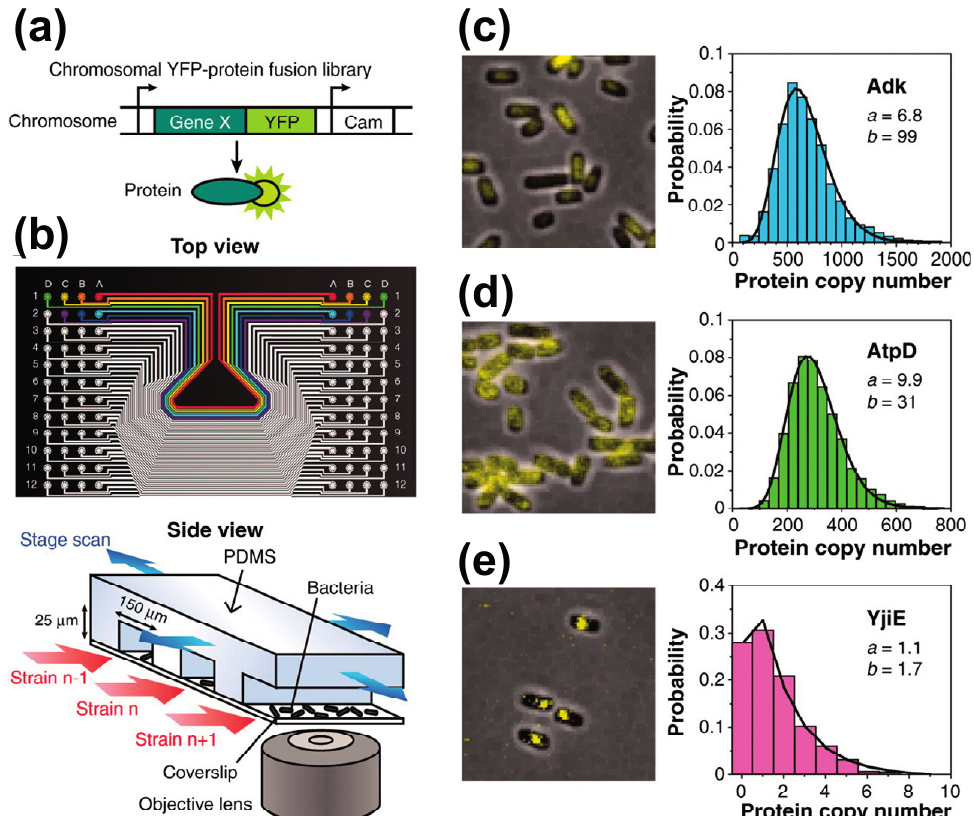
Figure 4. High-throughput single molecule fluorescence microscopy. ( a ) Chromosomal YFP fusion E. coli library. In each library strain, a YFP is translationally fused to the C-terminus of a protein in its native chromosomal position. ( b ) Microfluidic chip for imaging 96 library strains. Each strain is immobilized on a polylysine-coated coverslip and is scanned with a single molecule fluorescence microscope. ( c – e ) Three examples from a library of E. coli strains are shown. Images to the left are representative fluorescent images overlaid on phase-contrast images; histograms to the right are the distribution of copy numbers. Lines are curve fits to gamma distributions with parameters a and b . Taken from